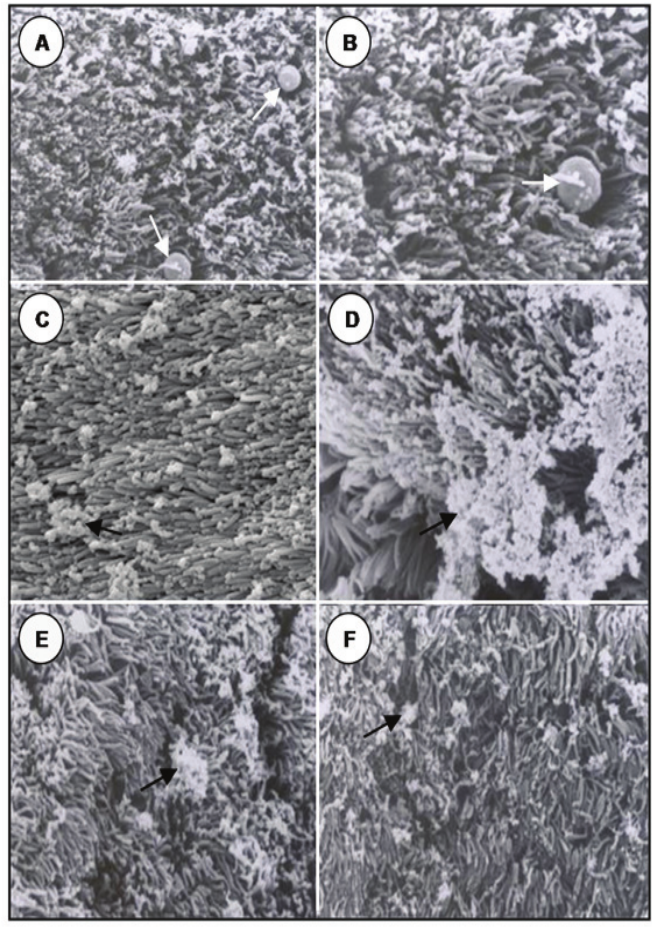
FIGuRE 5 - Proximal tracheal epithelium (ET group). Scanning electron microscopy showing ciliary disorganization and disorientation on epithelial surface and mucus droplet (arrows) of normal aspect being expelled to the epithelial surface ( A – x 2,760; B – x 4,825); adhering cilia forming small groupings (arrows; C – x 3,500; d – x 4,825); more intense ciliary disorientation and grouping (arrows; E – x 4,440; F – x 3,885). Transmission electron microscopy (TEM) demonstrated similar aspect with ciliated, goblet and basal cells. Numerous cilios could be identified on the apical portion of ciliated